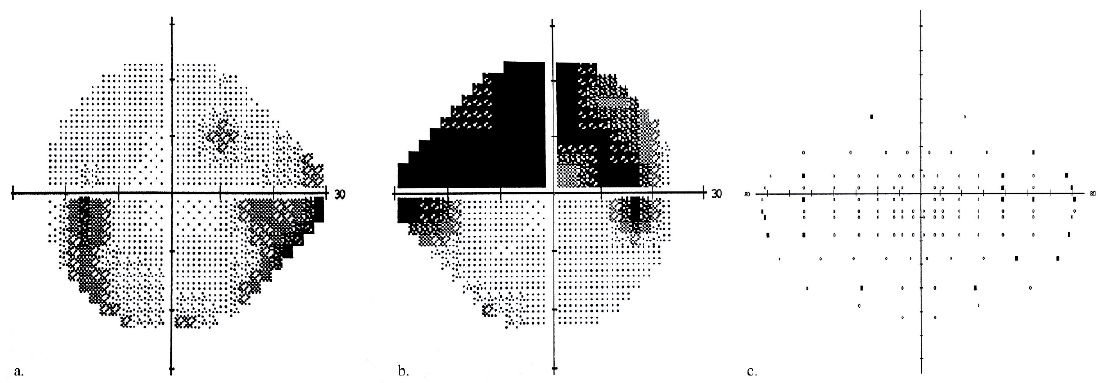
Figure 1. Example of a visual field defect in a glaucoma patient ( gray scale ): ( a ) left eye MD of − 4.79 dB, ( b ) right eye MD of − 14.64 dB, ( c ) binocular VF defect of 20 (out of 120), and a Esterman coefficient score of 83.